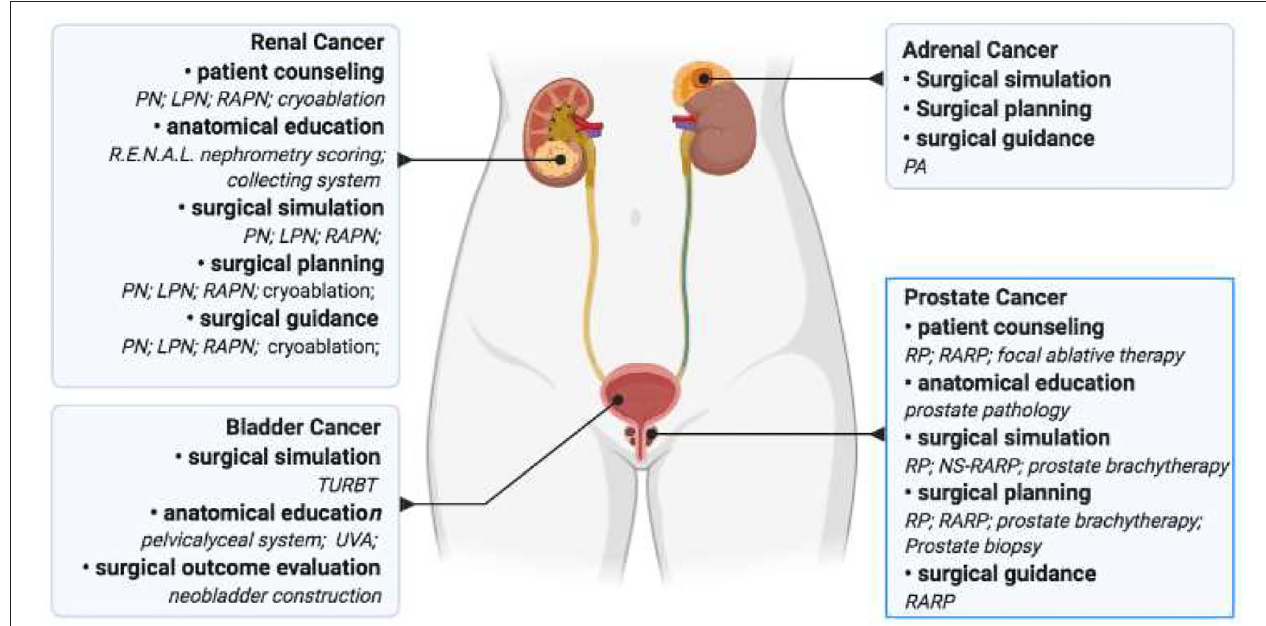
FIGURE 2 | The application of 3D printing in urologic cancer. 3D printing was utilized in patient and traineeeducation, surgical simulation, as well as surgical planning and guidance in urologic cancer research. PN, partial nephrectomy; LPN, laparoscopic partial nephrectomy; RAPN, robot-assisted partial nephrectomy; PA, partial adrenalectomy; TURBT, transurethral resection of bladder tumor; UVA, uretherovesical anastomosis; RP, radical prostatectomy; RARP, robot-assisted radical prostatectomy; NS-RARP, nerve- sparing robot-assisted laparoscopic radical